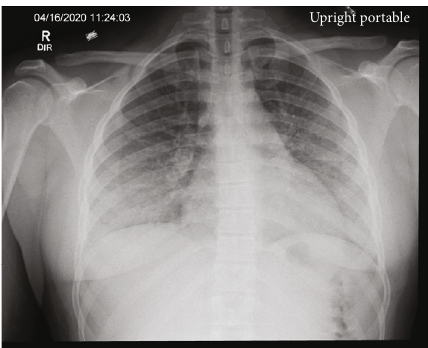
Figure 1: Chest X-ray: di ff use bilateral lung in fi ltrates with basilar